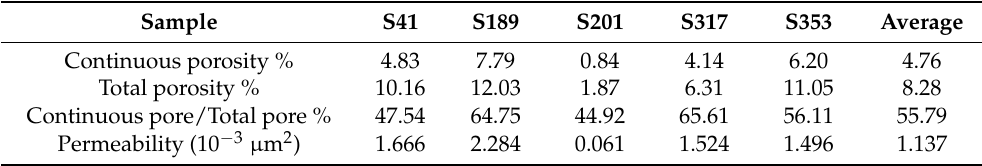
Table 2. Total porosity, continuous porosity and permeability of the studied